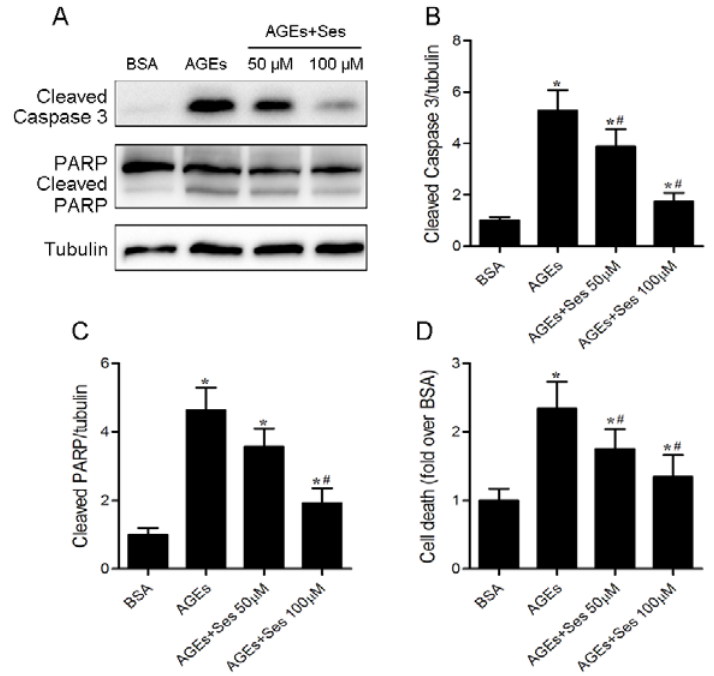
Figure 6. Effects of sesamin on apoptosis in MIN6 cells. Cells were prepared as in Figure 5. ( A ) Panel shows representative bands of cleaved caspase 3 and PARP. Histograms represent optical density values of cleaved caspase 3 ( B ) and PARP ( C ) normalized to the corresponding tubulin. ( D ) Apoptosis in MIN6 cells was determined by DNA fragmentation using the Cell Death Detection ELISA Plus assay kit. Values are expressed as mean ± SD, n = 3–4. * p < 0.05 versus BSA. # p < 0.05 versus AGEs.